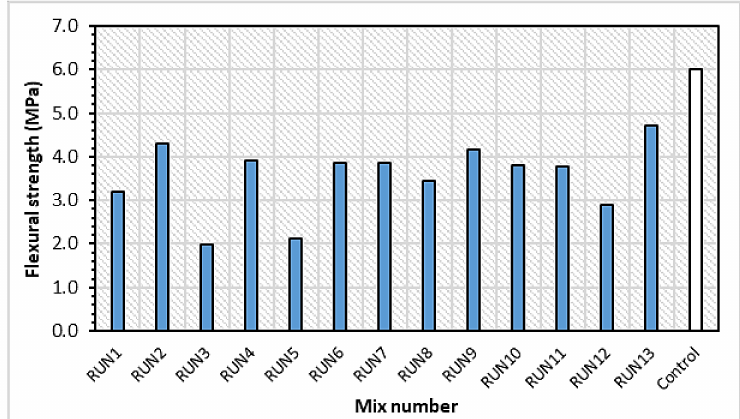
Figure 11. Flexural strength of the HVFA–CRC mixes at 28